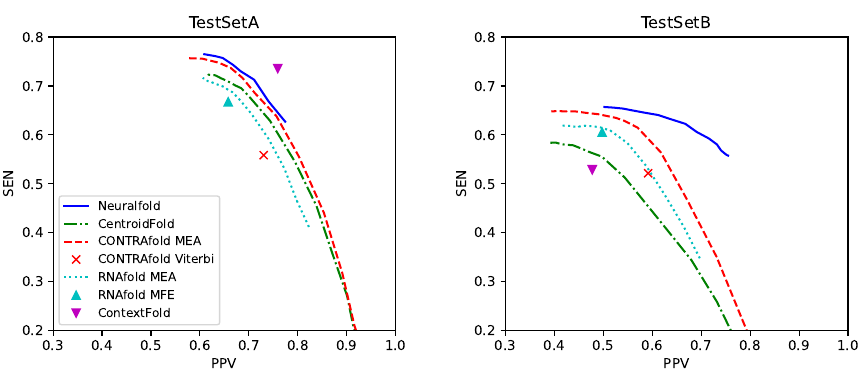
Figure 5. Positive predictive value–sensitivity (PPV–SEN) plots comparing our algorithm with competitive methods on TestSetA ( Left ) and TestSetB ( Right ).